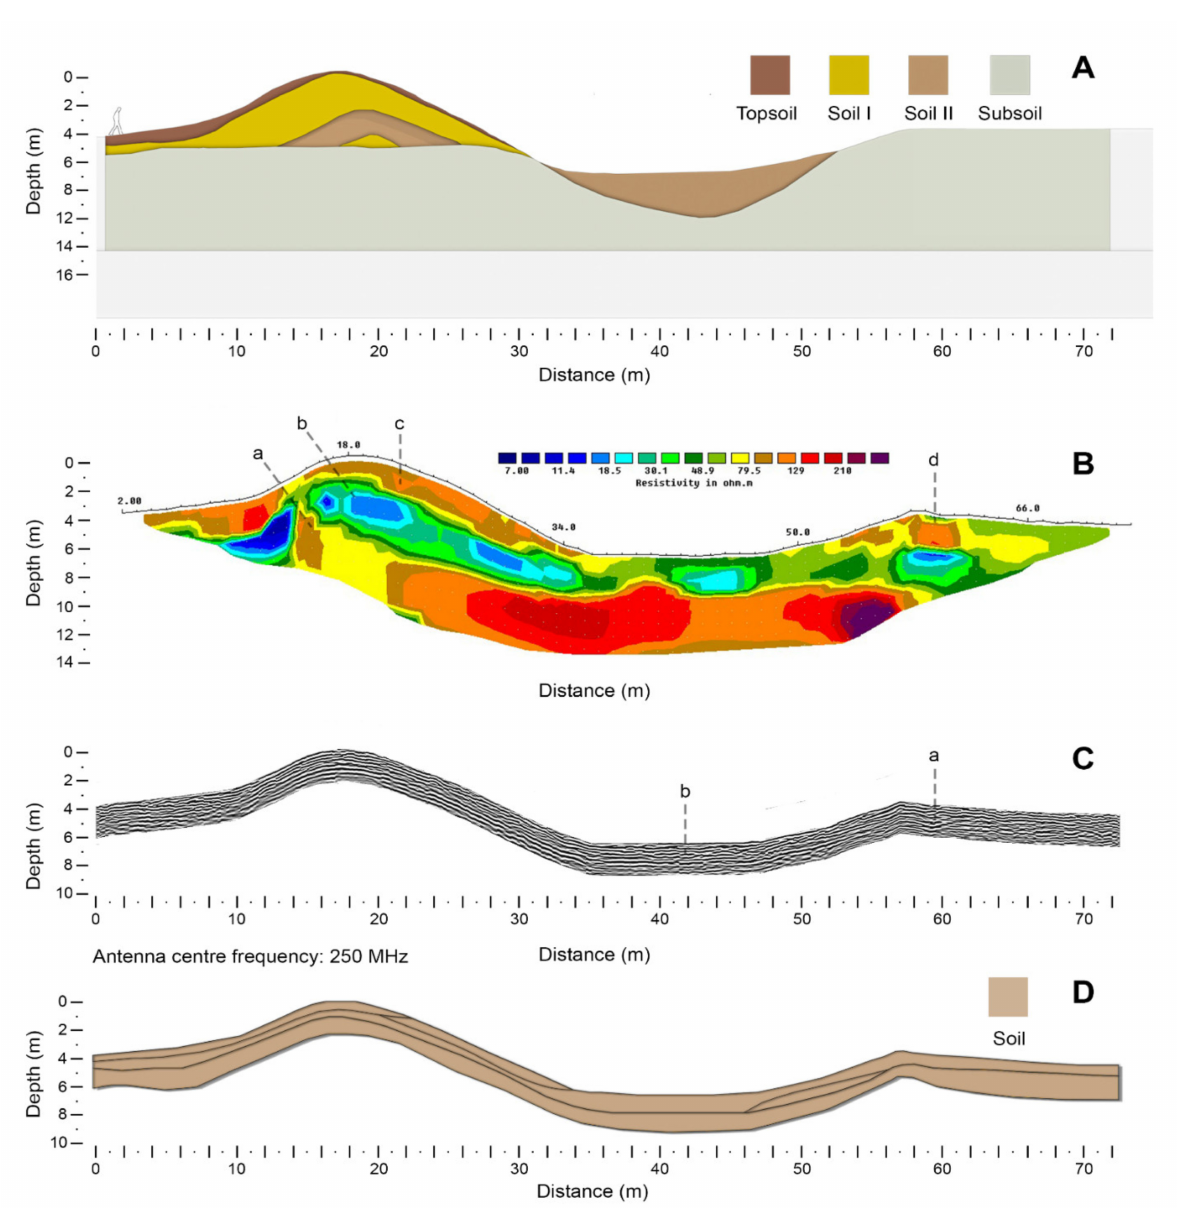
Figure 3. B í ˇna. ( A ): Profile of the hillfort’s fortification based on the results of archaeological excava- tion ([37], Figure 15). ( B ): Electrical resistivity tomography model in Wenner configuration. ( C ): GPR vertical time/depth radarogram from an antenna with 250 MHz centre frequency. ( D ): Interpretation of the GPR